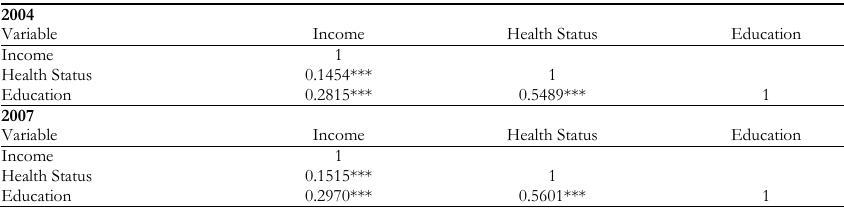
Correlation structure: pair-wise correlation